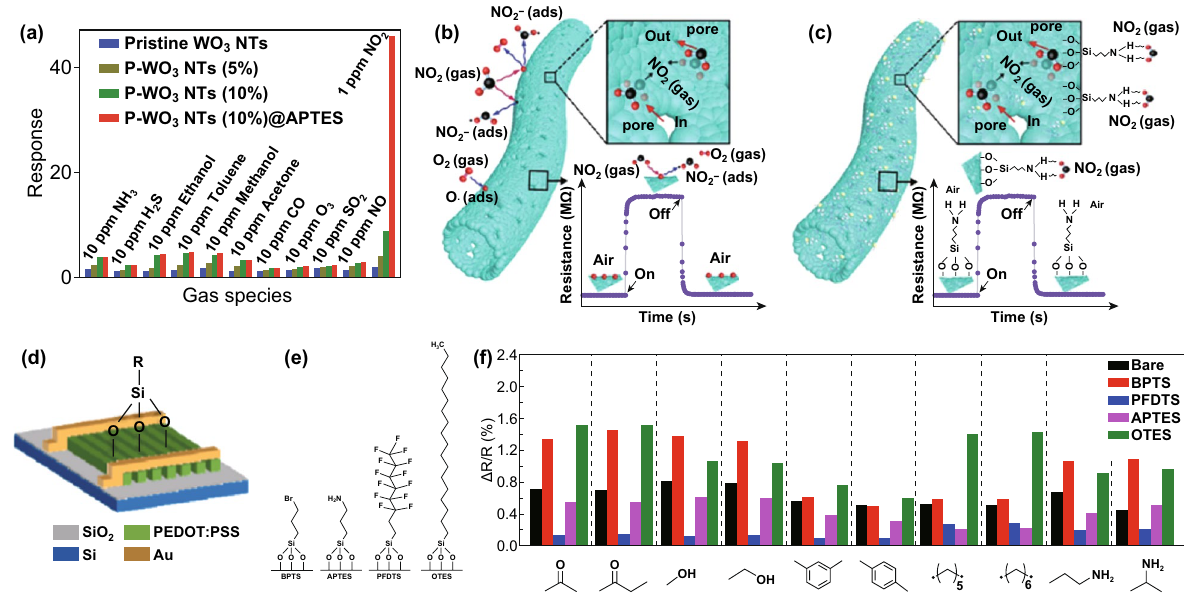
Fig. 15 a Selectivity comparison of different gas sensors at the corresponding operating temperature. Schematic illustration of the NO 2 sens- ing mechanism of sensors based on b P-WO 3 NTs (10%) and c P-WO 3 NTs (10%)@APTES. Reproduced with permission [71]. Copyright 2018, Royal Society of Chemistry. d The schema of silane-coated PEDOT:PSS sensor. e The molecular chain of different silane-coated on PEDOT:PSS. f Response to VOCs. Reproduced with permission [72]. Copyright 2018, Royal Society of